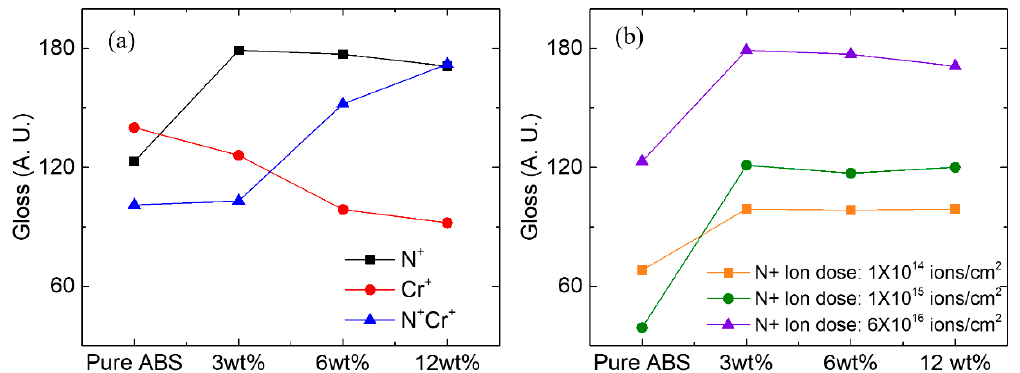
Figure 10. ( a ) Change of glossiness after irradiation with ( a ) nitrogen ion beam according to difference in irradiation amount and ( b ) nitrogen, chromium, nitrogen, and chromium ion beam irradiation under 1.8 × 10 16 ions cm − 2 .